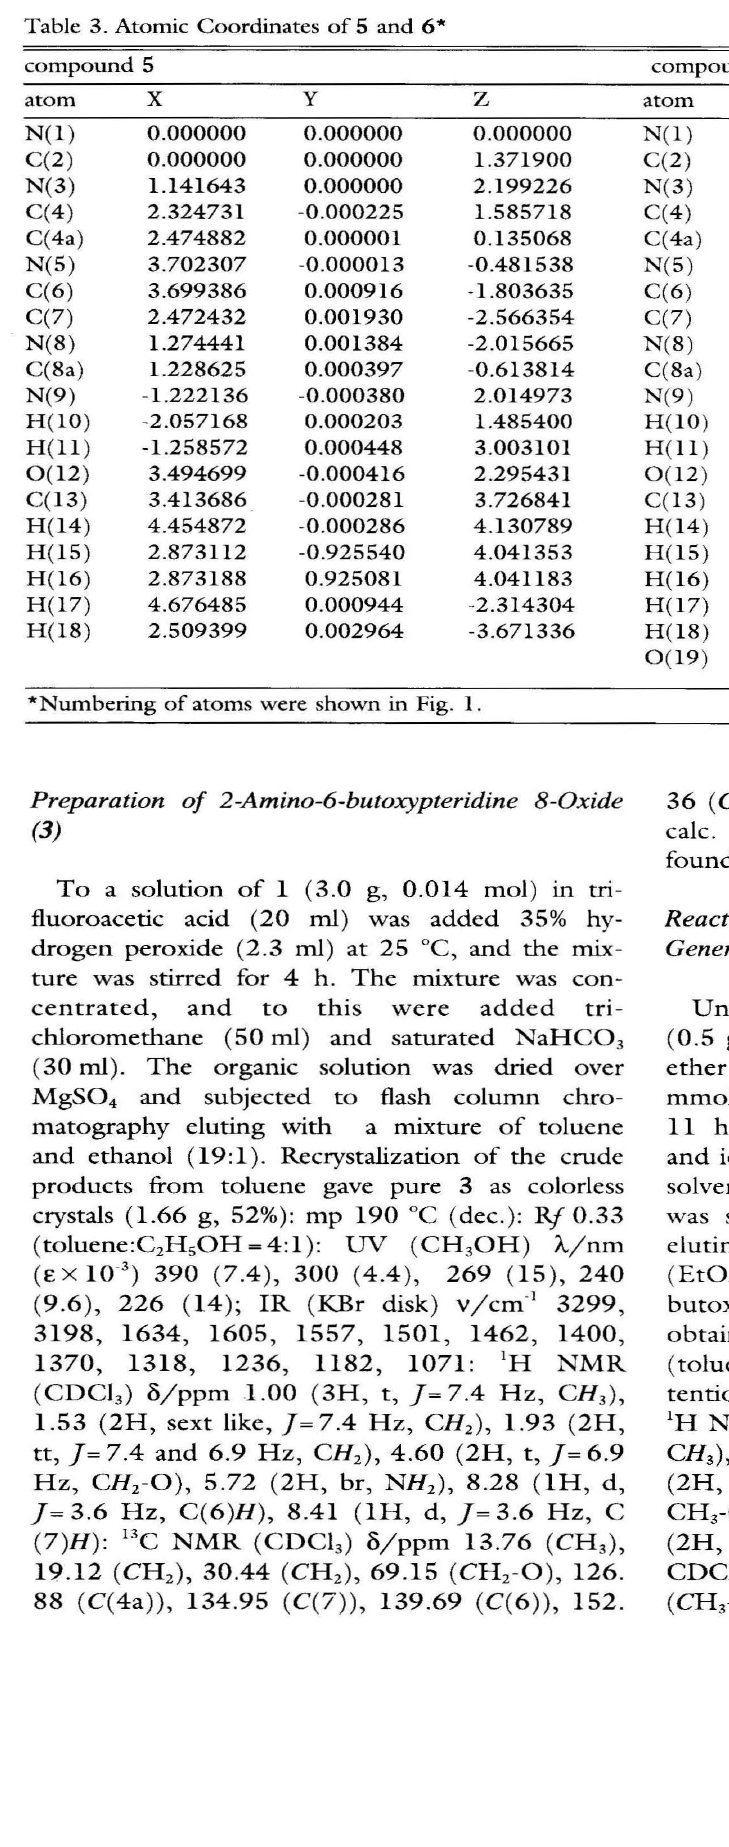
Table 3. Atomic Coordinates of 5 and 6* compound